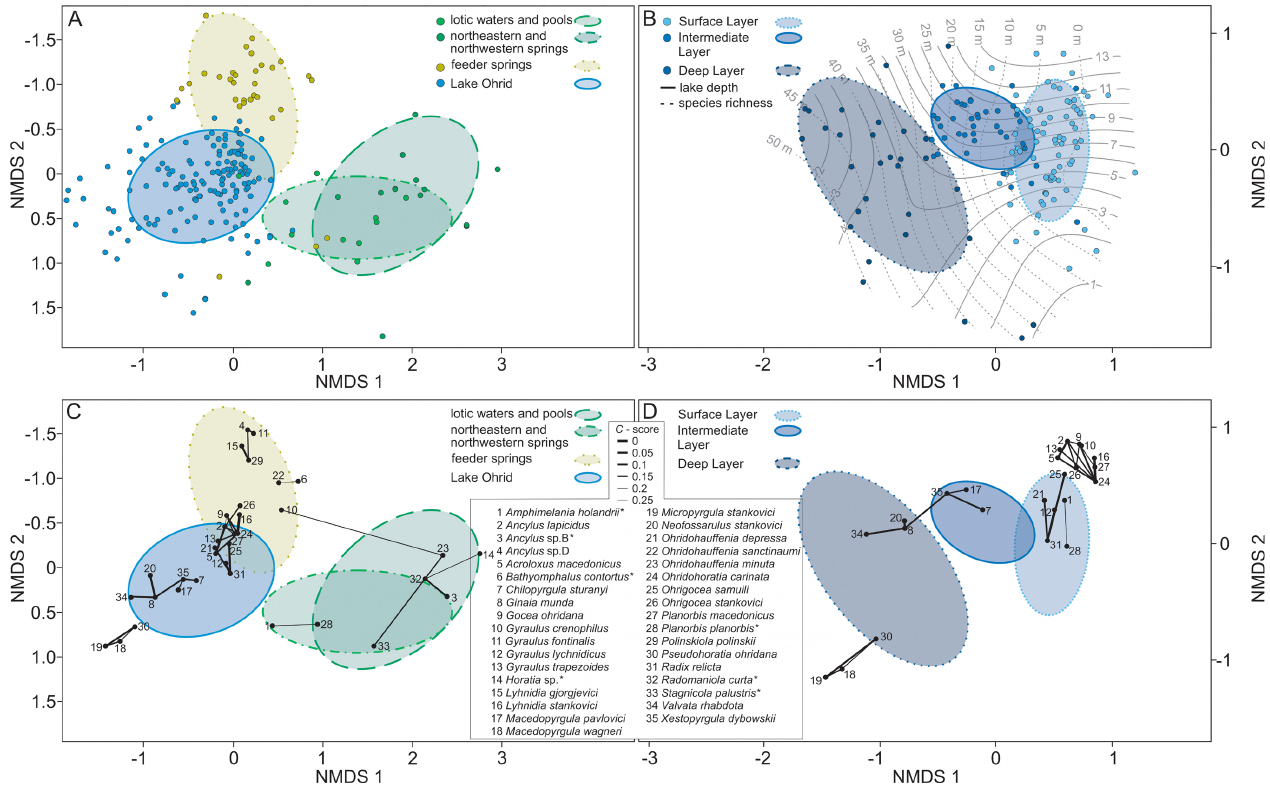
Fig. 3. NMDS plots of gastropod communities (Bray-Curtis dissimilarity). (A) Two-dimensional solution within the Ohrid Basin showing little similarity among horizontal zones. (B) Vector fitting of collecting depth and species richness for the three-dimensional solution within Lake Ohrid showing community turnover correlated with collecting depth. (C) Species joint plots of the ordination within the Ohrid Basin, and (D) within Lake Ohrid indicating non-random co-occurrence of species by line connection. Widespread species are marked by asterisks and line widths correspond to the degree of species